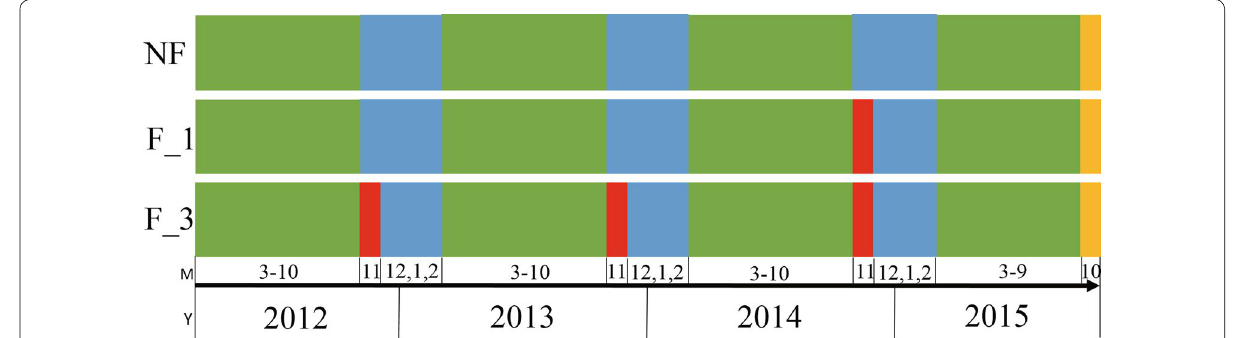
Fig. 1 The sample processing information. The green represents ginger growth period. The blue represents fallow period. The red represents fumi- gated treatment. The yellow represents sample collection period. M month, Y year, NF non-fumigation, F_1 chloropicrin-fumigation for 1 year, F_3 continuous chloropicrin-fumigation for 3